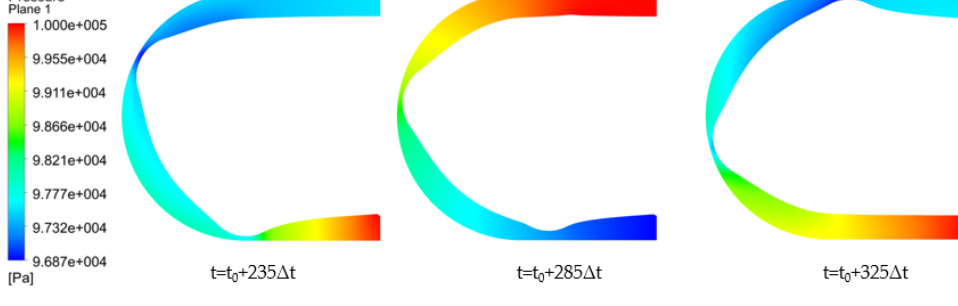
Figure 9. Static pressure distribution of the 0 MPa outlet pressure at different speeds.